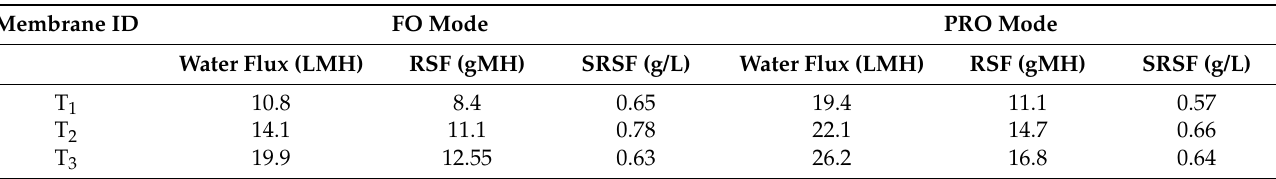
Table 5. Thin-film composite (TFC) FO membrane performance under FO and PRO modes using 2 M NaCl as DS and DI as FS modes. Membrane